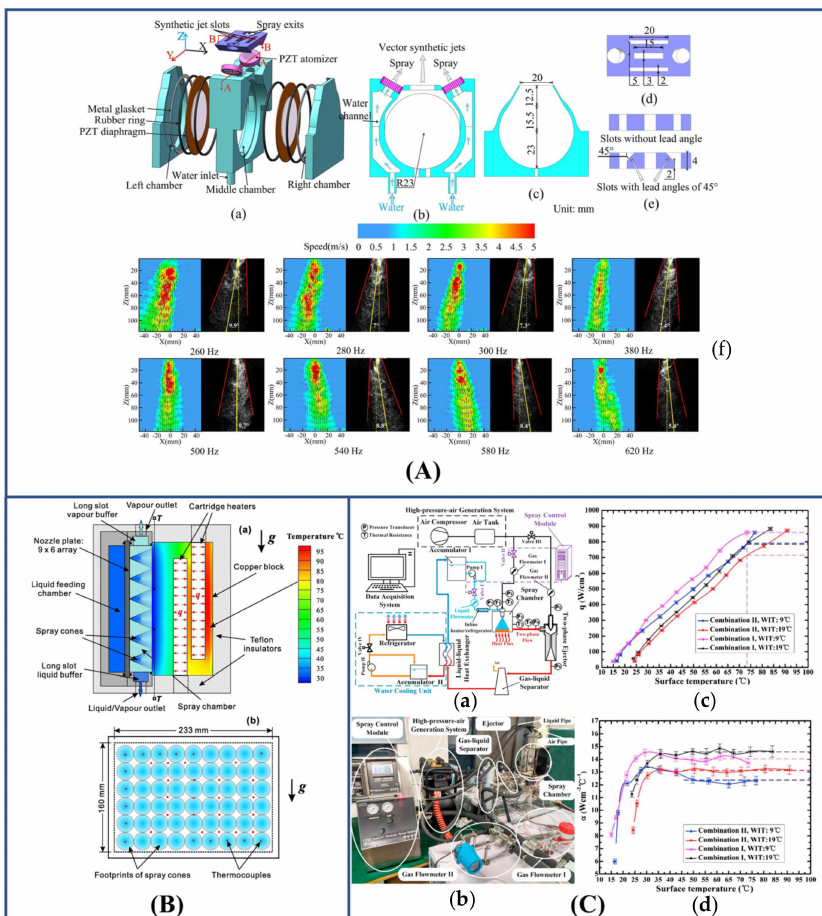
Figure 9. Design, research and analysis of spray cooling structure and system of electronic devices.